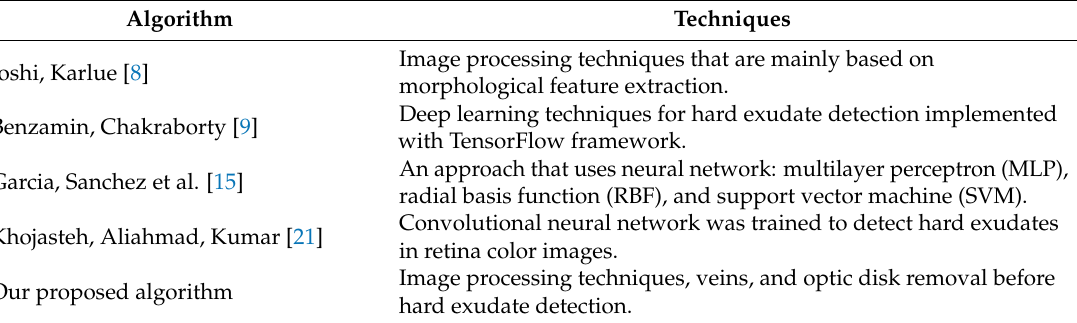
Table 5. Summary of the used